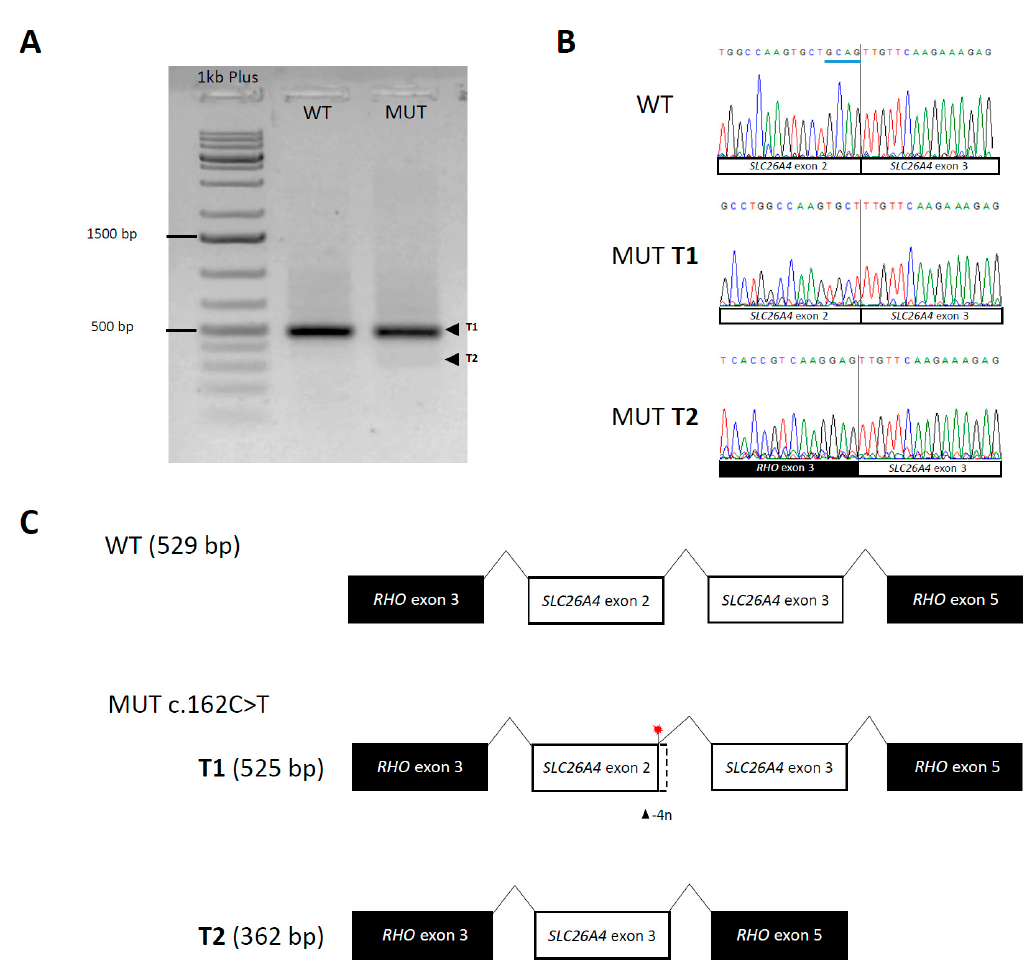
Figure 1. Results of minigene assay for the SLC26A4 c.162C>T variant. Introduction of the c.162C>T variant resulted in creation of two mutated transcripts—T1 with novel donor site at c.160 and shortened by four nucleotides, and T2 lacking exon 2. ( A ) The SLC26A4 transcripts visualized with gel electrophoresis. ( B ) Results of the Sanger sequencing of wild type and mutated transcript. ( C ) Schematic representation of wild type and mutated transcripts. WT, wild type; MUT, mutant; T1, transcript 1; T2, transcript 2; bp, base